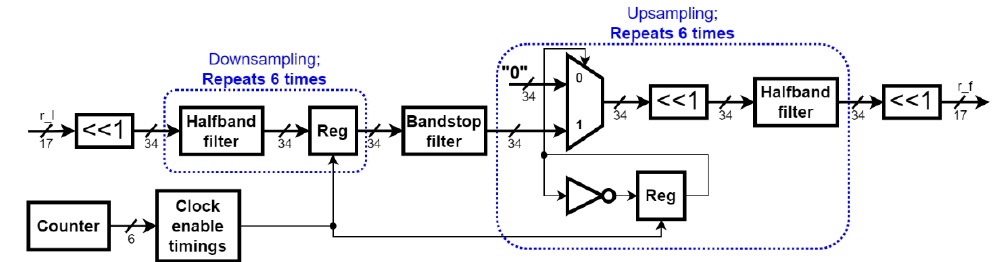
Figure 13. Filtering system structure.